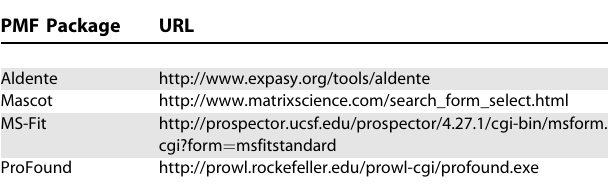
Table 1. A Short List of Popular PMF Packages PMF